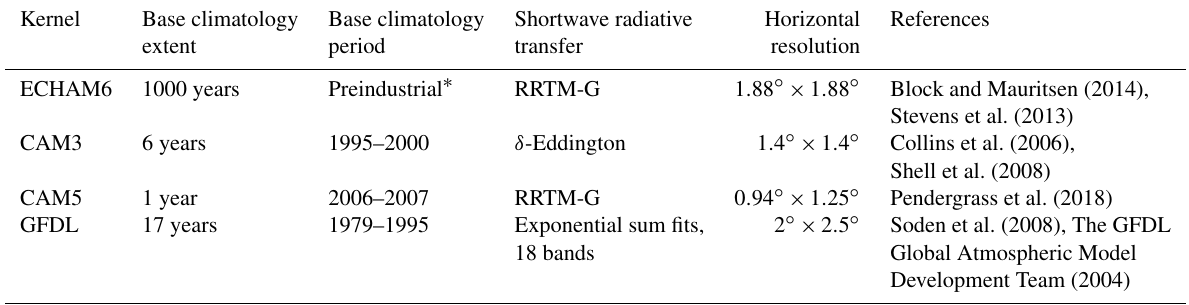
Table 1. Attributes of existing GCM kernels, all of which having a monthly temporal resolution.